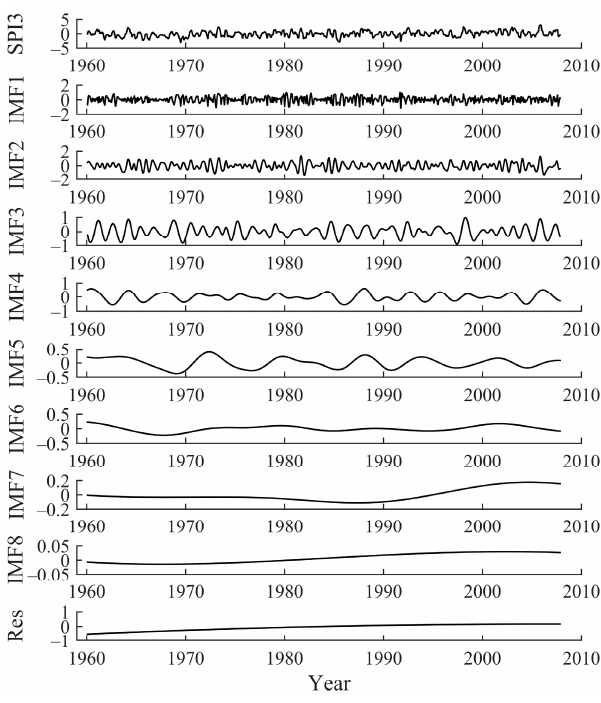
Figure 9. The CEEMD decomposition results of SPI3 sequence.